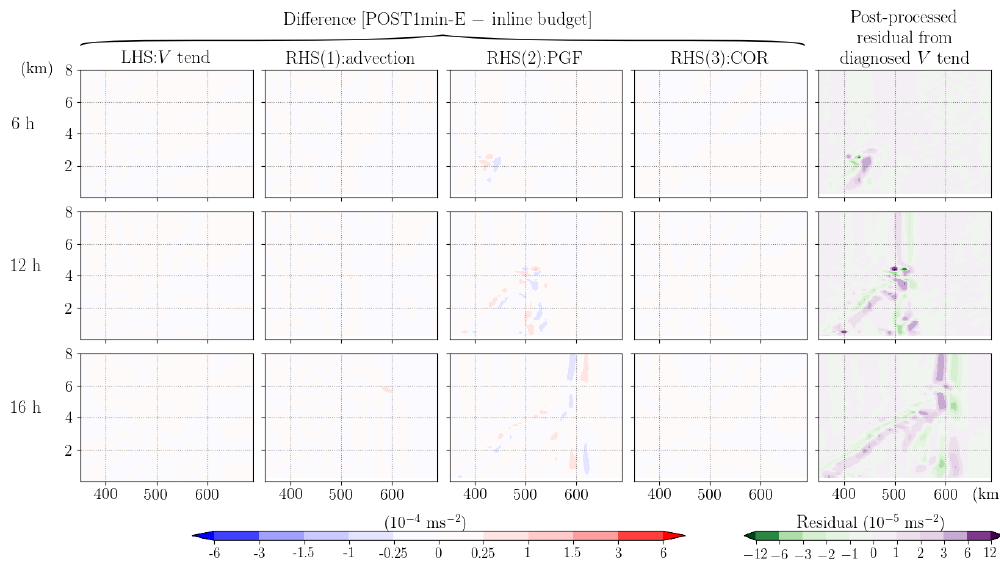
Figure 9. Same as Fig. 8, but the post-processed budget analysis is applied to the data with an output time interval of 1min